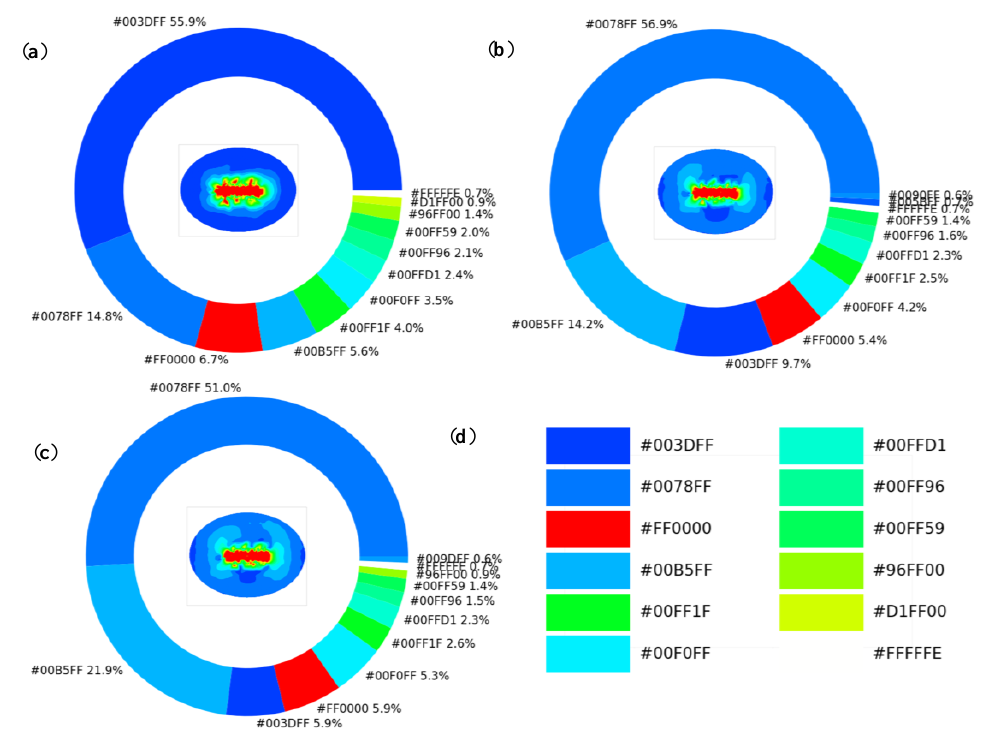
Figure 16. Digitization of velocity distribution on Plane 4; ( a ) Digitization of velocity distribution for CVB; ( b ) Digitization of velocity distribution for SWB; ( c ) Digitization of velocity distribution for RWB; ( d ) Color codes.